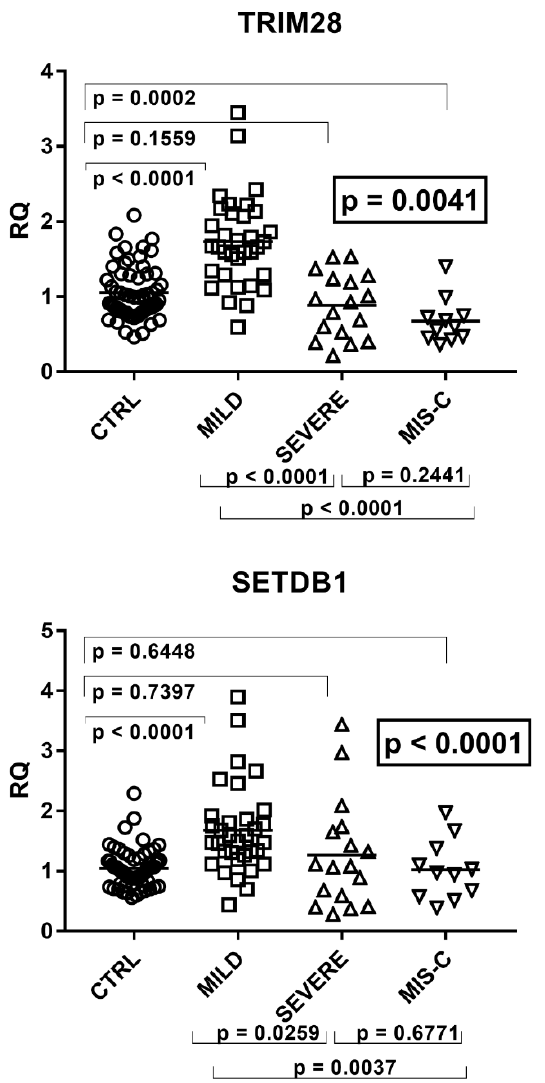
Figure 4. Expression of TRIM28 and SETDB1 in whole blood from 64 children with SARS-CoV-2 infection and 60 uninfected children. CTRL: uninfected control children. MILD: infected children with mild/moderate symptoms. Severe: infected children with severe disease. MIS-C: infected children with multisystem inflammatory syndrome. RQ: relative quantification. Circles, squares, and triangles show the median of three individual measurements, horizontal lines the median values.